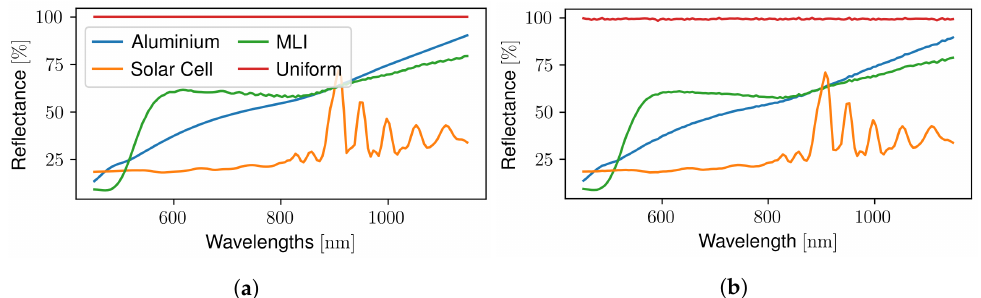
Figure 14. Spectral reflectance signatures of common spacecraft materials. ( a ) Lab measurements assigned to the simulation model. ( b ) Extracted signatures using Automatic Target Generation Process